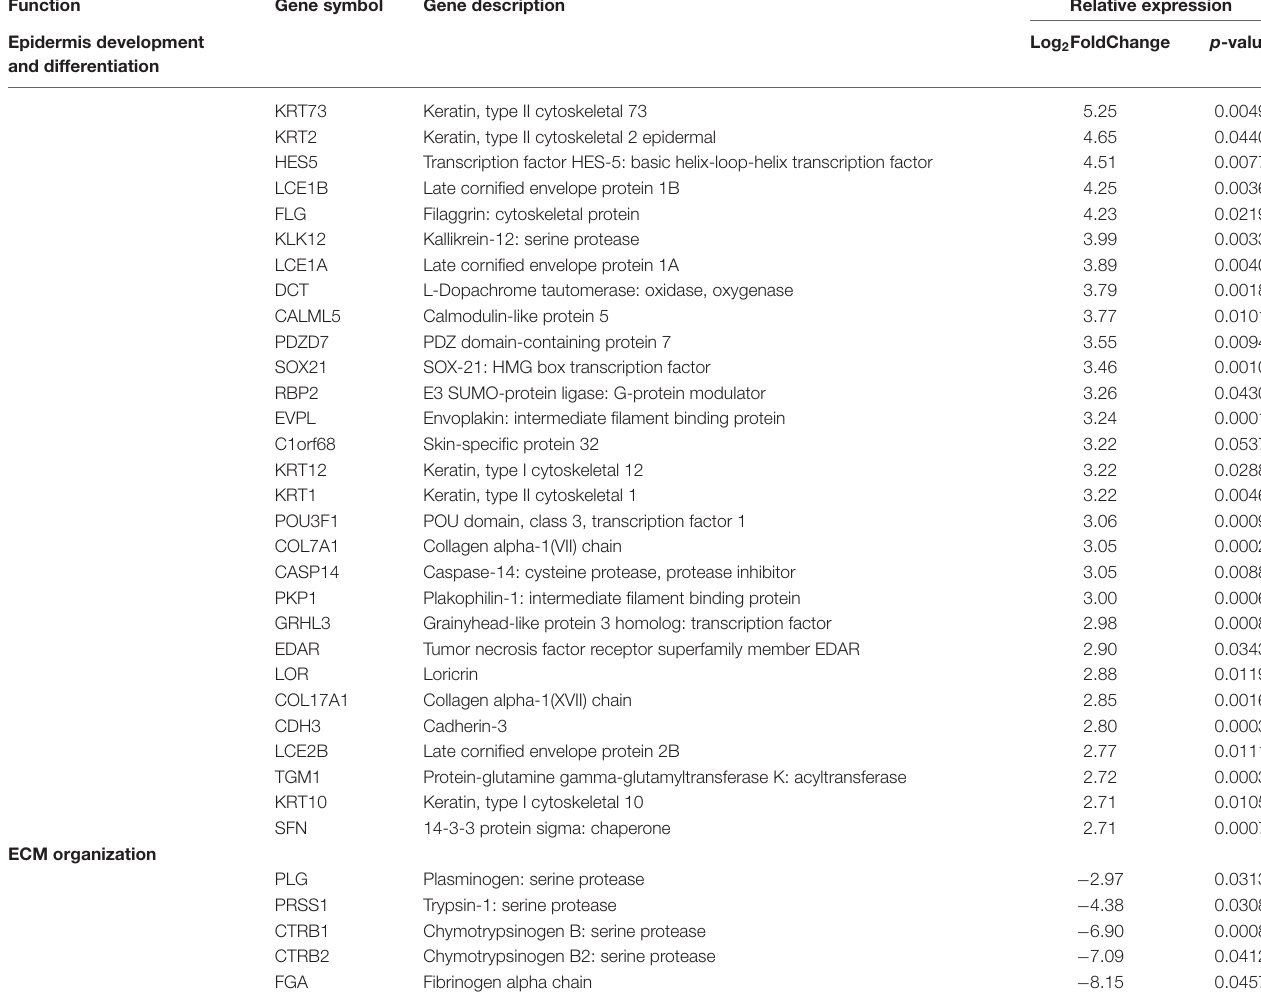
TABLE 7 | Pediatric inactive localized scleroderma vs. healthy control sample comparison identifies gene enrichment groups of interest related to fibrotic signatures. Function Gene symbol Gene description Relative